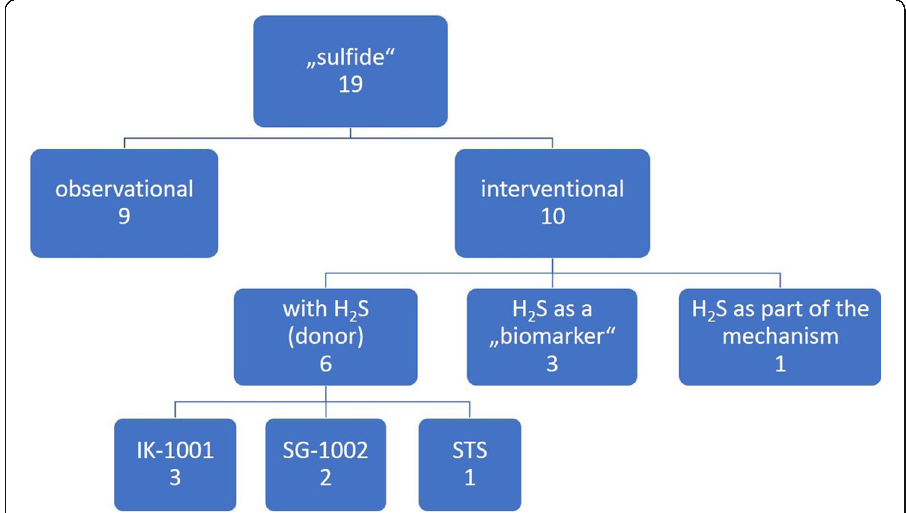
Fig. 2 Clinical trials found with the search term “ sulfide ” on clinicaltrials.gov and relevant to intensive care. Excluded: skin diseases, halitosis, dental conditions, colonoscopy, and